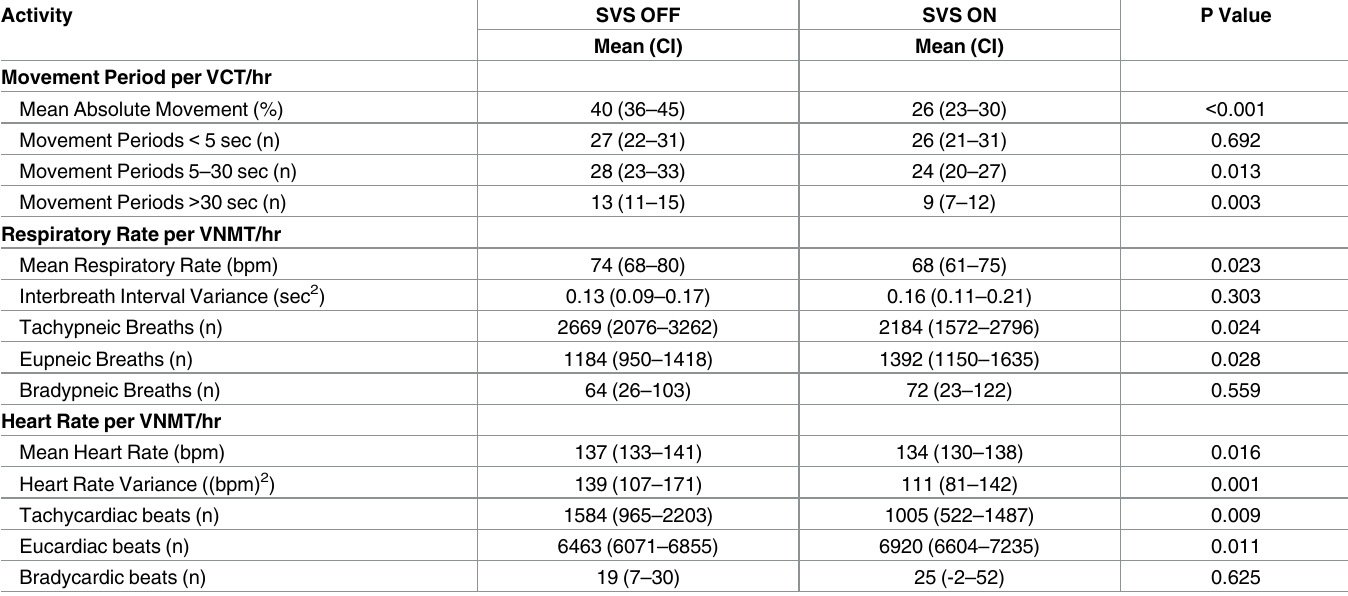
Table 2. Effects of SVS on movement and cardio-respiratory